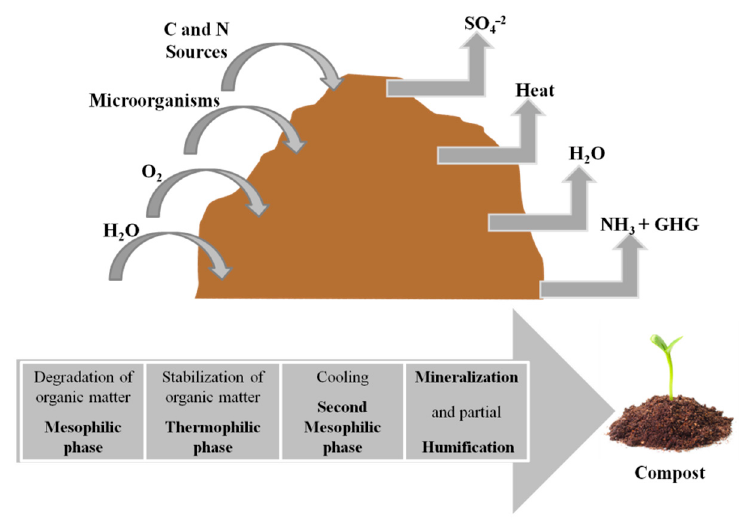
Figure 2. Scheme of the composting process. GHG, greenhouse gases.